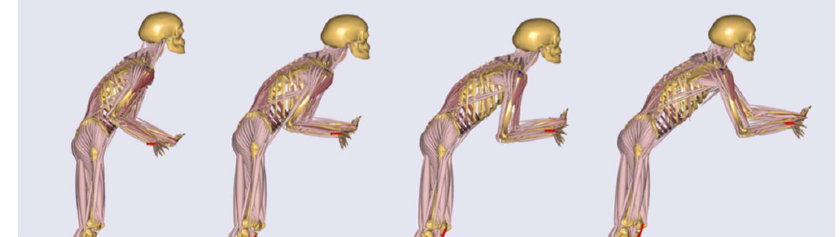
Figure 7. Dynamic human model in push movement illustrated as a sequence of images from the beginning to the end of the pushing. The motion is taken from a captured movement sequence, however it is subjectively defined as being representative of the movement. Within the described dynamic modeling framework, the mechanical exoskeleton concepts were implemented and iteratively optimized.